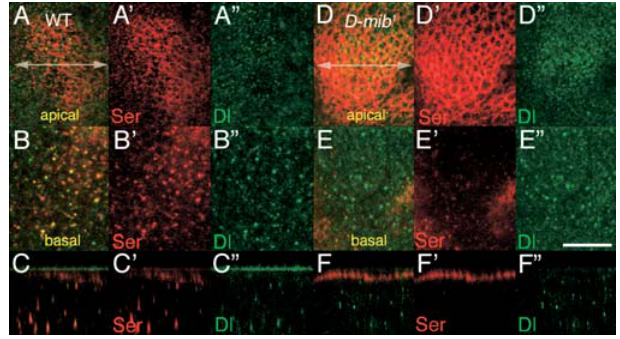
Figure 5. D-mib Is Required for Ser Endocytosis Localization of the anti-Ser (red) and anti-Dl (green) antibodies that have been internalized by wild-type (A–C 99 ) and D-mib 1 mutant (D–F 99 ) cells in the notum region of wing discs. (A–A 99 ) and (D–D 99 ) show apical sections and (B–B 99 ) and (E–E 99 ) show basal sections. (C–C 99 ) and (F–F 99 ) show confocal z-sections. The z-section axes are shown with a double- headed arrow in (A) and (D). Internalized anti-Ser and anti-Dl antibodies co-localized in wild-type cells. In contrast, high levels of anti-Ser antibodies were detected at the cell surface of D-mib mutant epithelialcellswhereasanti-Dlantibodieswereefficientlyinternalized. Bar is 10 l m for all panels. DOI: 10.1371/journal.pbio.0030096.g005 PLoS Biology |